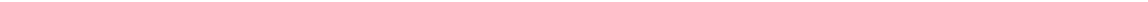
Fig. 2. Archegonaspis species from the East Baltic and Severnaya Zemlya Archipelago. A–E , Archegonaspis schmidti (Geinitz): A, anterior portion of the dorsal shield, the rostral, small part of central and right lateral epitega, GIT 171-1 (previous number Pi 5027, re-imaged from Märss 1977a); B, large anterior portion of the dorsal shield in visceral view; C, close-up of (B) with a small piece of bone broken off from the left lateral side exhibiting the mould of sculpture; D, detail of (B) with impressions of individual exhalent canals of gill pouches (note small pits at the bottom of each hollow), GIT 721-2; E, rostral epitegum, LIG 25-022 (re-imaged from Märss 1977a); F , Archegonaspis ? lindstroemi Kiaer: anterior part of the right branchial plate, GIT 721-6; G , Archegonaspis lindstroemi Kiaer: partial rostral epitegum and postrostral field of central epitegum, GIT 171-2 (previous collection number Pi 5028, re-imaged from Märss 1977a); H , Archegonaspis integra (Kunth): a large fragment of the dorsal mid-shield, GIT 721-1. Scale bars = 5 mm. Locations : A, Edole core, depth 597.3 m, Latvia, Ludlow; B–D, Girdžiai-37 core, depth 1037.2–1037.4 m, Lithuania, Pagegiai Formation, Upper Ludlow; E, No. 1 core, depth 1535 m, Kaliningrad District, Birštonas Beds, Upper Wenlock; F, locality 2055v, Pioneer Island, Severnaya Zemlya Archipelago, Wenlock; G, Edole drill core, depth 594.1 m, Latvia, Ludlow; H, Reo-927 core, depth 8.9 m, Saaremaa, Tahula Beds of Kuressaare Stage, upper Ludlow, upper Silurian. Abbreviations (including impressions of internal organs, mainly from Novitskaya 2004, fig. 88): brp, branchial pouches; dr, double-ridge; ioc, individual exhalent canals; med, medulla; olf, olfactory organs; orb, orbital notch; pi, pineal organ; po, pores of possible branchial transverse commissure; sc, semicircular canal (here shown are anterior